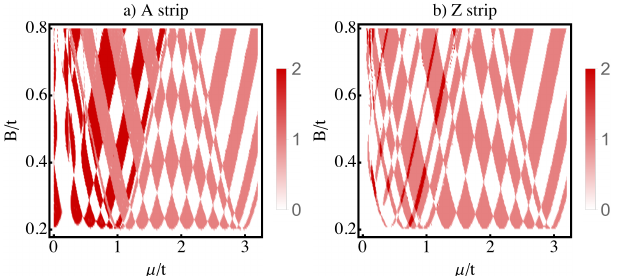
Figure 6: The total MP as a function of the chemical potential and magnetic field for A strips (left panel) and Z strips (right panel). We take W = 15 a , L = 432 a , α = 0.1 t and ∆ = 0.2 t